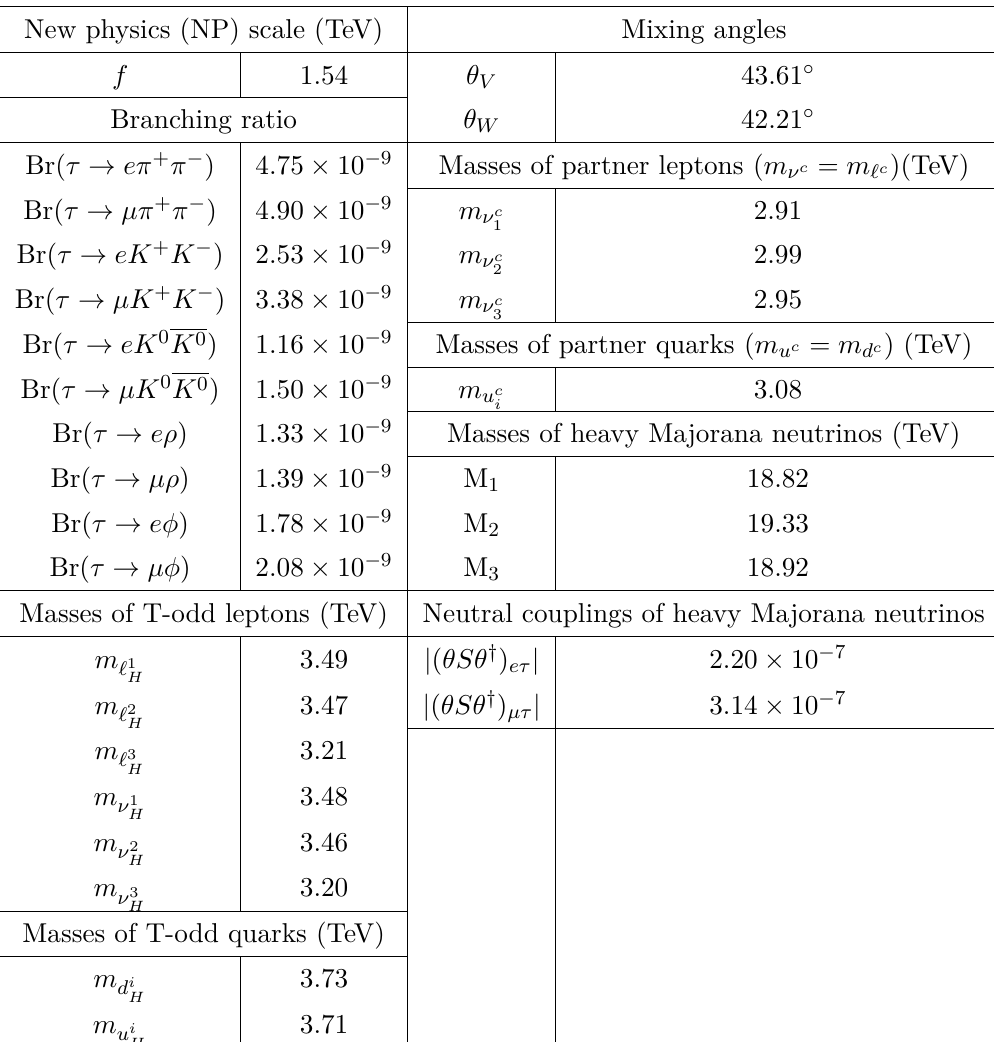
Table 5 . Mean values for branching ratios, masses of LHT heavy particles, mixing angles and neutral couplings obtained by Monte Carlo simulation of τ → ‘PP, ‘V ( ‘ = e, µ )